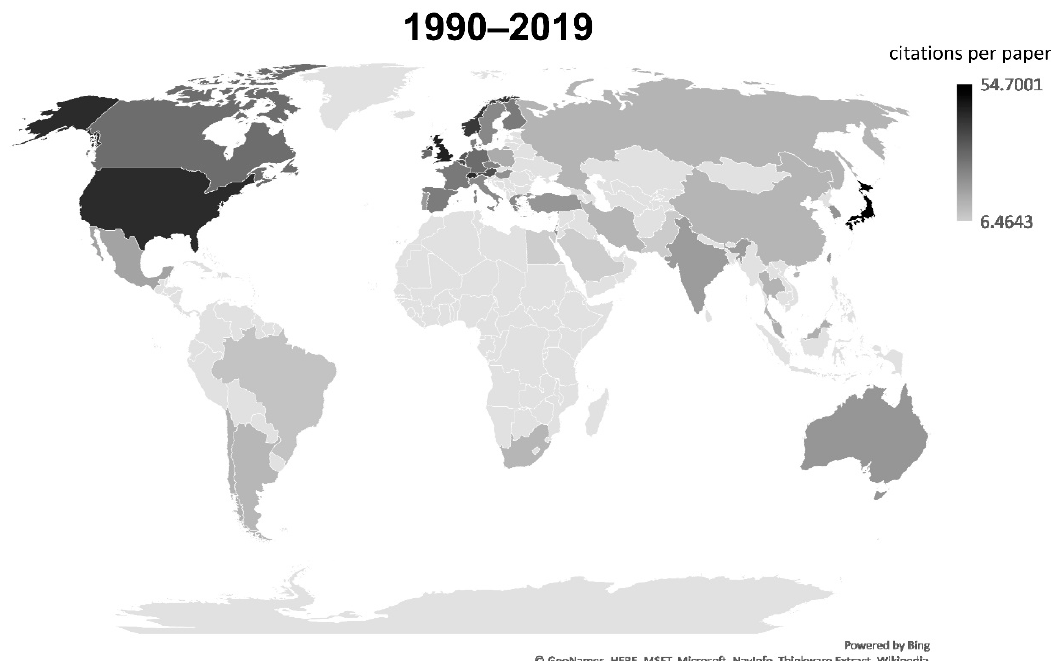
Figure 7. World map depicting the citations per Nrf2-related paper (averaged citations) published from each country from 1990 to July 2019. Each paper may have authors from more than one country (international collaboration). The higher the color density (darker grey to black) of a country, the larger the number of citations per Nrf2 paper. Note that “England”, “Scotland”, “Wales” and “Northern Ireland” records from the “Web of Science” were combined into “UK”. Only countries with at least 20 publications are depicted.